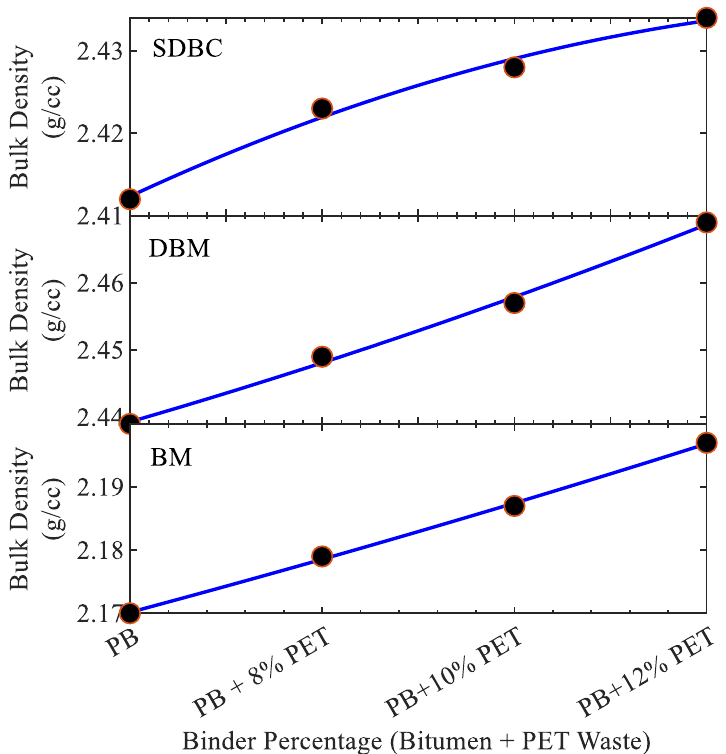
Fig. 26 Relations between bulk density and binder content for modified SDBC, DBM, and